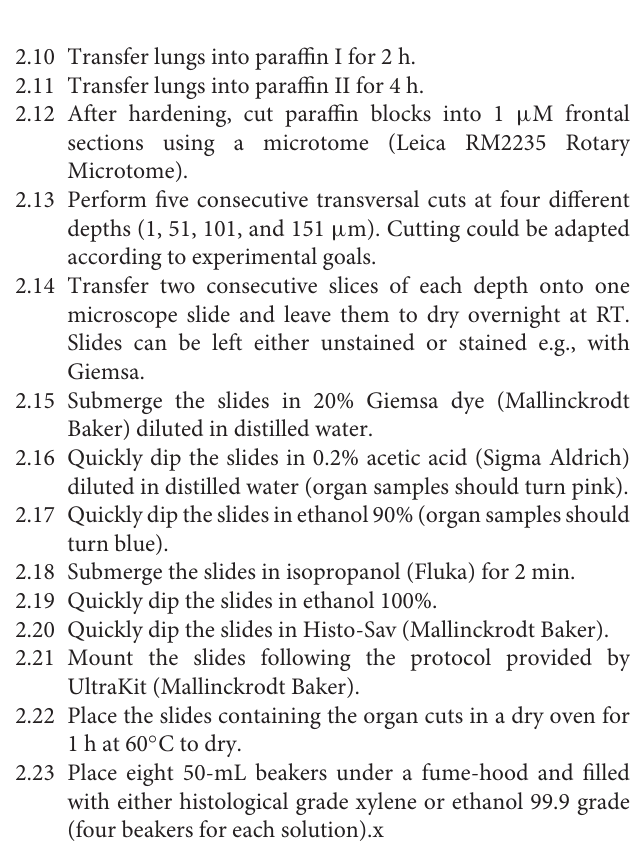
FIGURE 1 | Graphic protocol scheme Summary of the RNAScope staining protocol and the different steps involved. (1) Baking of the paraffinized slides at 60 ◦ C. (2) Deparaffinization of slides with subsequent washes in xylene and ethanol. (3) Permeabilization of the slide and incubation with a target retrieval solution. (4) Probe hybridization with target RNA. (5) Signal amplification with subsequent staining with FastRed dye. (6) Counterstaining of the lung tissue with Hematoxylin. (7) Mounting of the slides. (8) Visualization under a brightfield microscope and image acquisition. (microscope schematic from